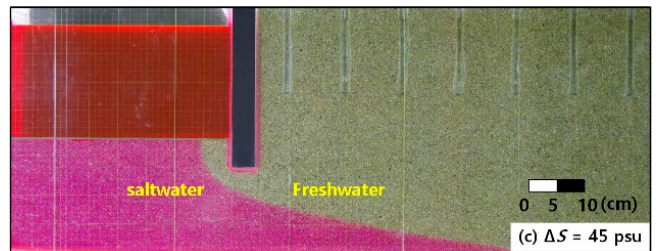
Figure 4. Pressure-equilibrium state between saltwater (red) and freshwater (light green) in a coastal aquifer with a seawall for h = 20 cm and Δ h = 1 cm at Δ S of ( a ) 25 psu, ( b ) 35 psu, and ( c ) 45 psu.